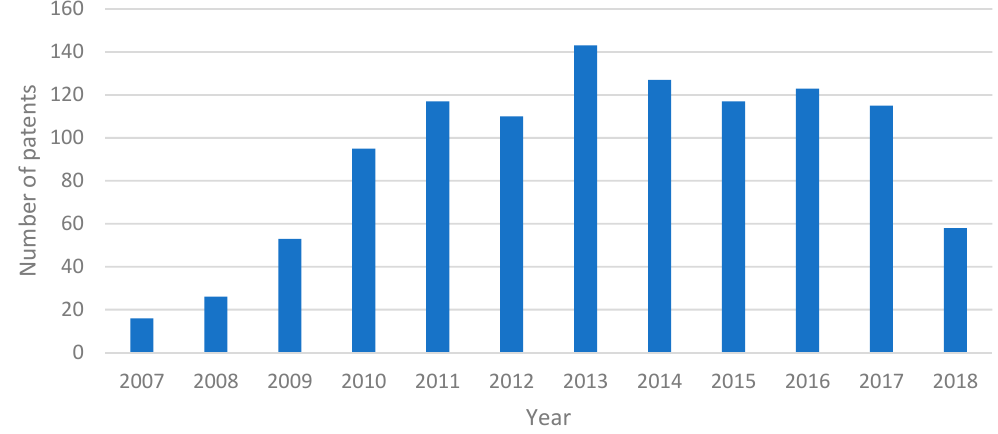
Figure 5. Annual number of published patents between 2007 and 2018.